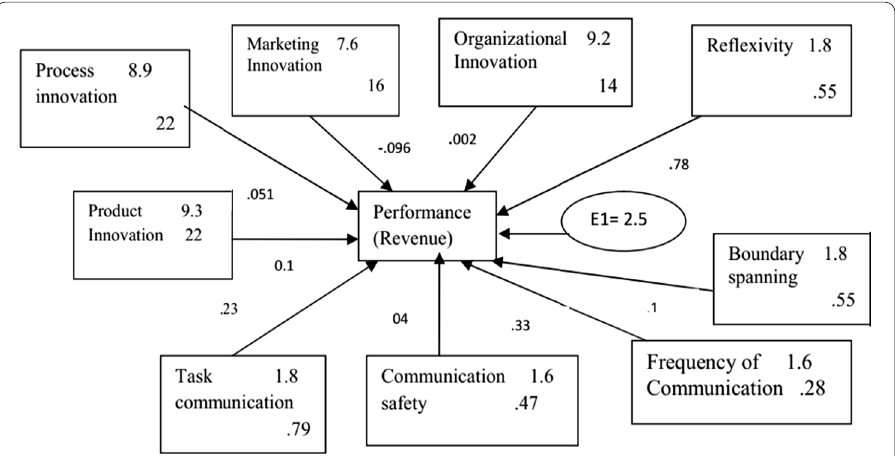
Fig. 9 SEM model result in its structure